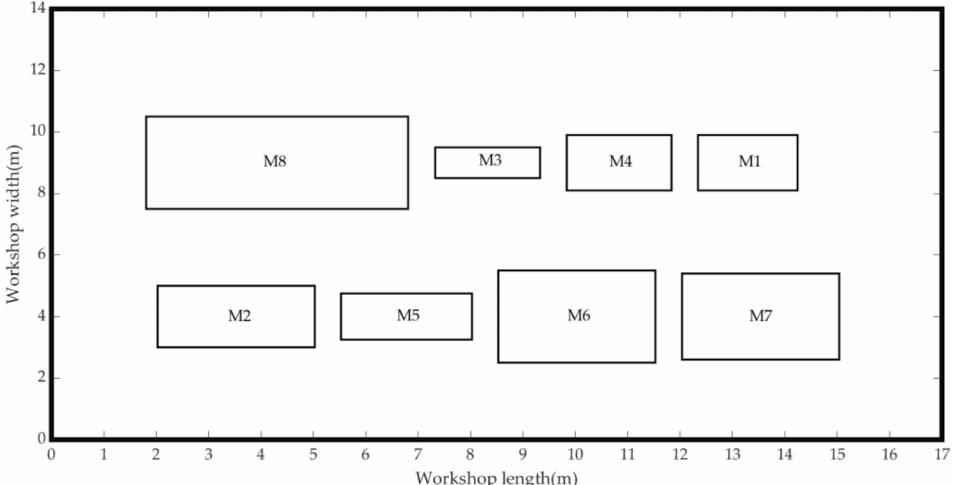
Figure 18. The layout scheme of solution